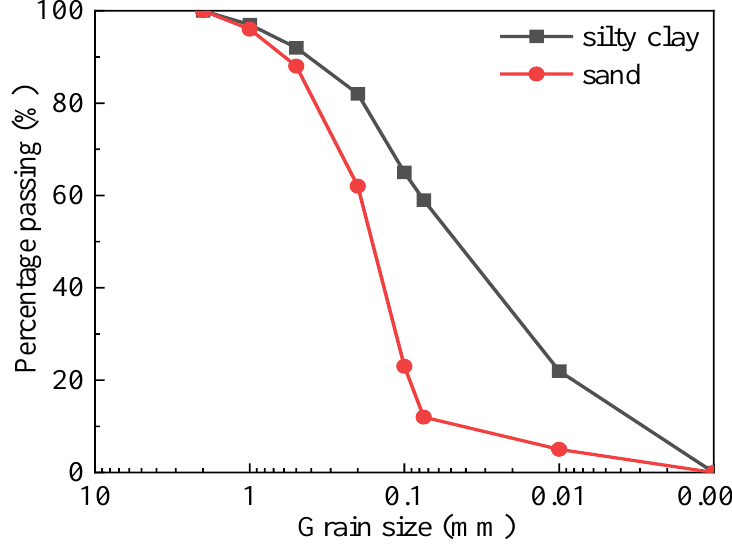
Figure 1. Remoulded fine- grained materials from Section K1013 along the Qinghai−Tibet railway: ( a ) frozen soil map of China; ( b ) Qinghai−Tibet railway; ( c ) section K1013 site; ( d ) remoulded fine- grained materials.